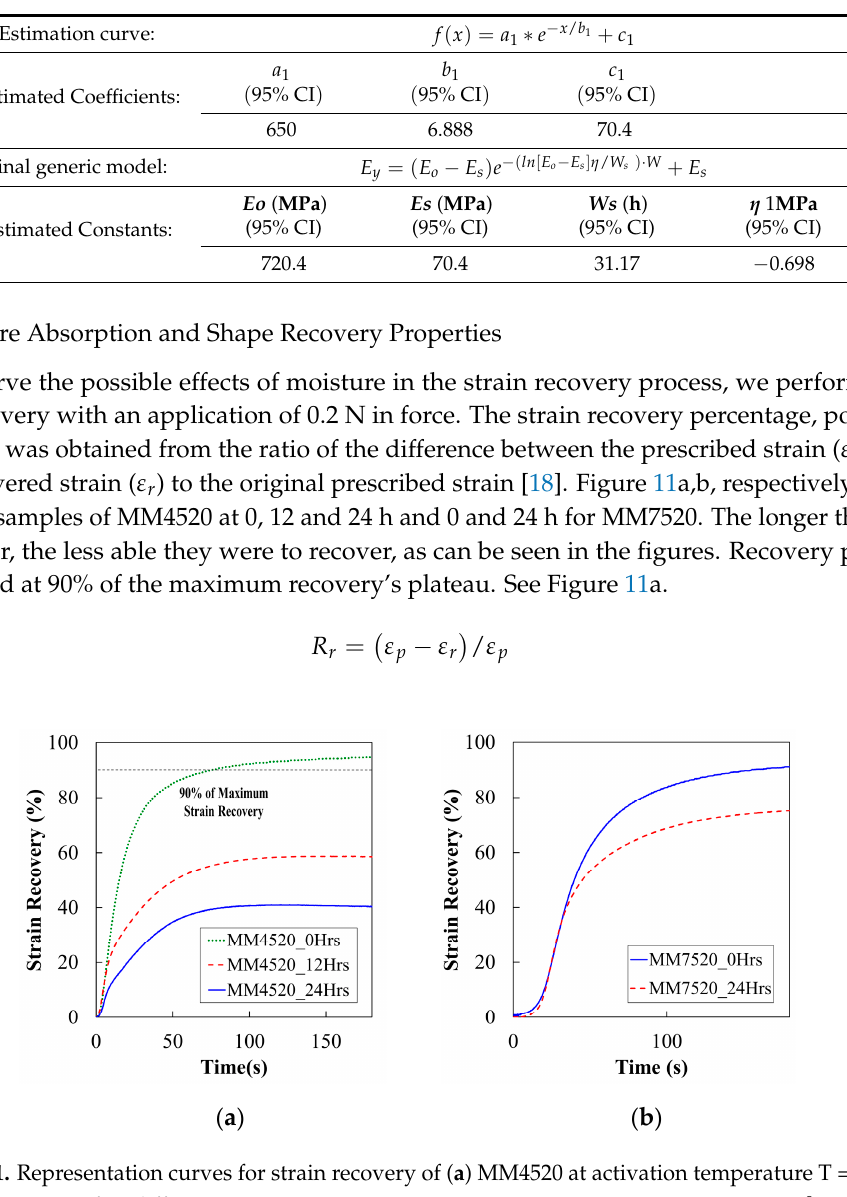
Table 3. Estimated coefficients for MM4520 elastic modulus with respect to immersion time in water.